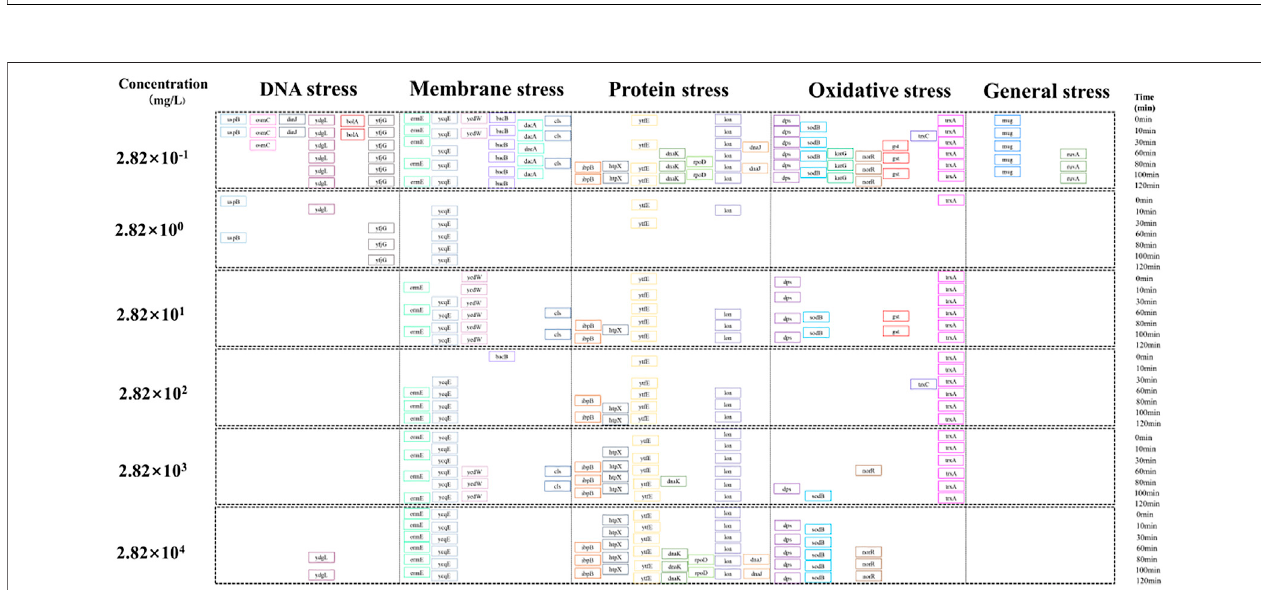
FIGURE 6 | 3D altered TELI pro fi le compiled from altered gene expression levels for all genes in the test library for different SUC concentrations. Note that only selected genes are shown on the x-axis.